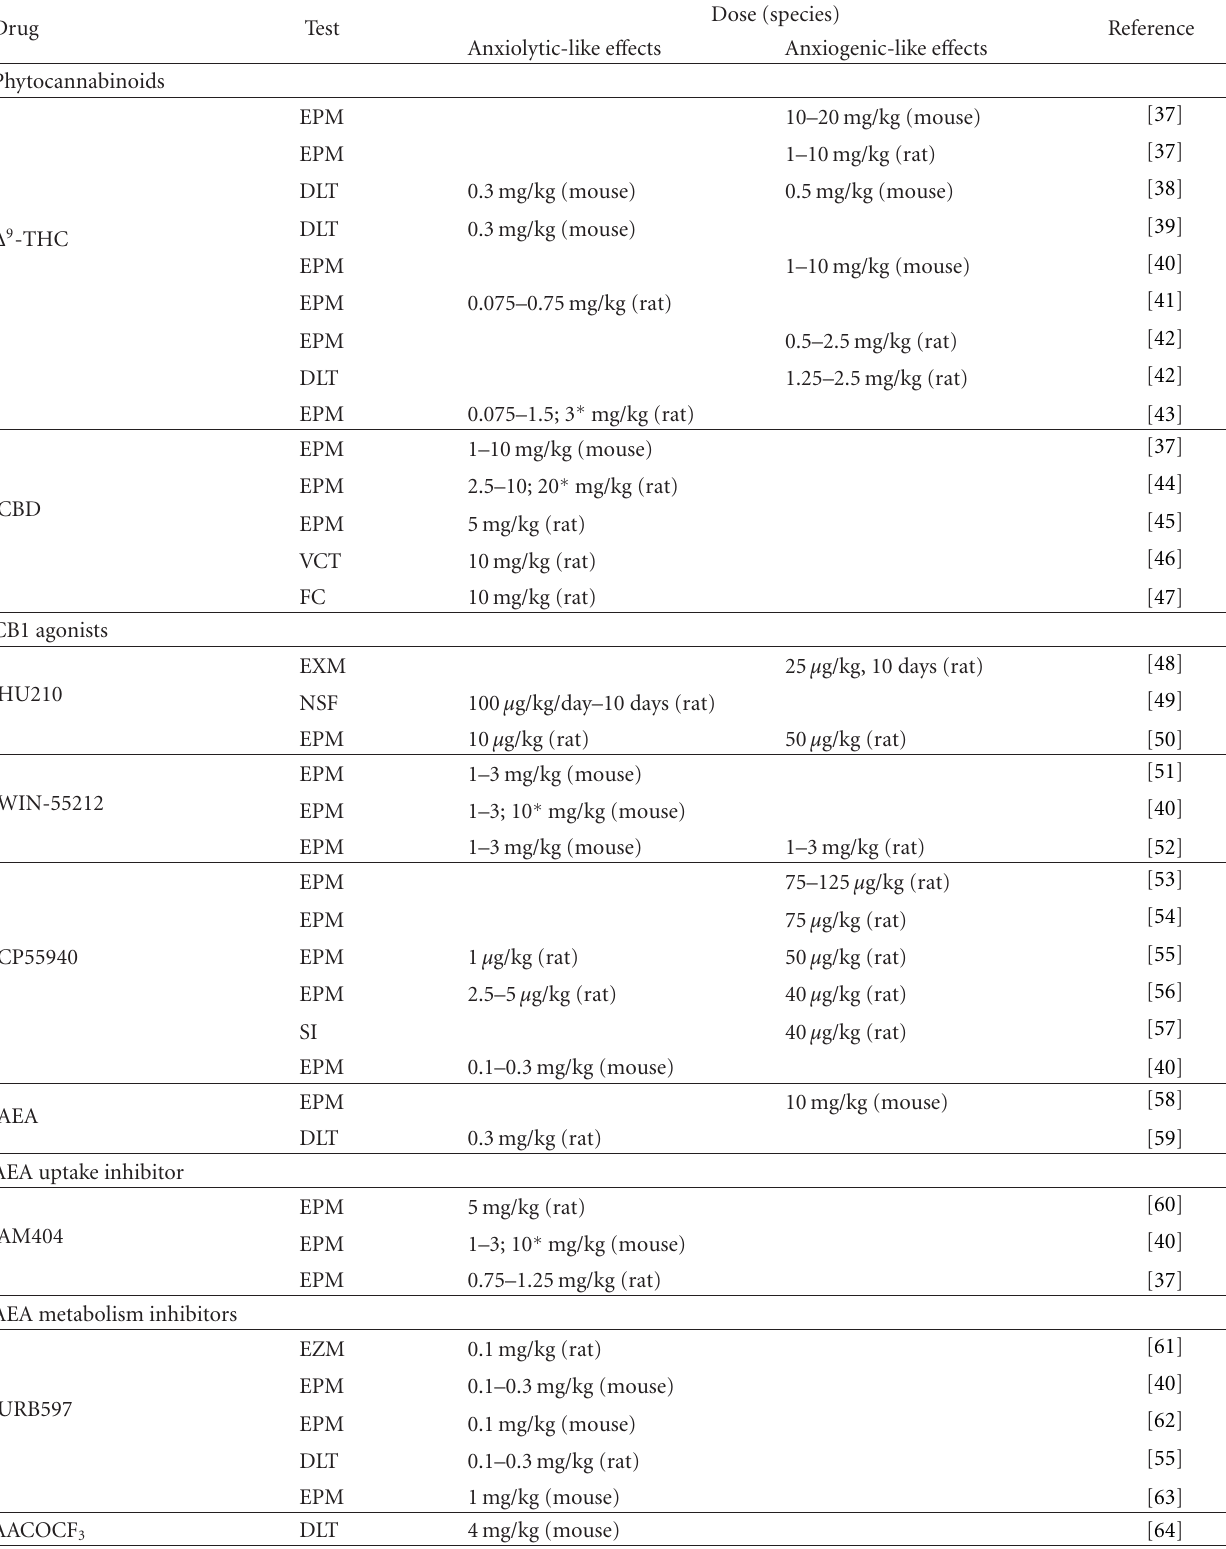
Table 1: E ff ects of cannabinoids and drugs that interfere with the endocannabinoid system in animal models predictive of anxiolytic- or anxiogenic-like activity. (AEA: AEA; Δ 9 -THC: Δ 9 -tetrahydrocannabinol; CBD: cannabidiol; EPM: elevated plus-maze; EXM: elevated X- maze; EZM: elevated zero-maze; VCT: Vogel conflict test; FC: fear conditioning; DLT: dark-light test; SI: social; NSF: novelty-suppressed feeding